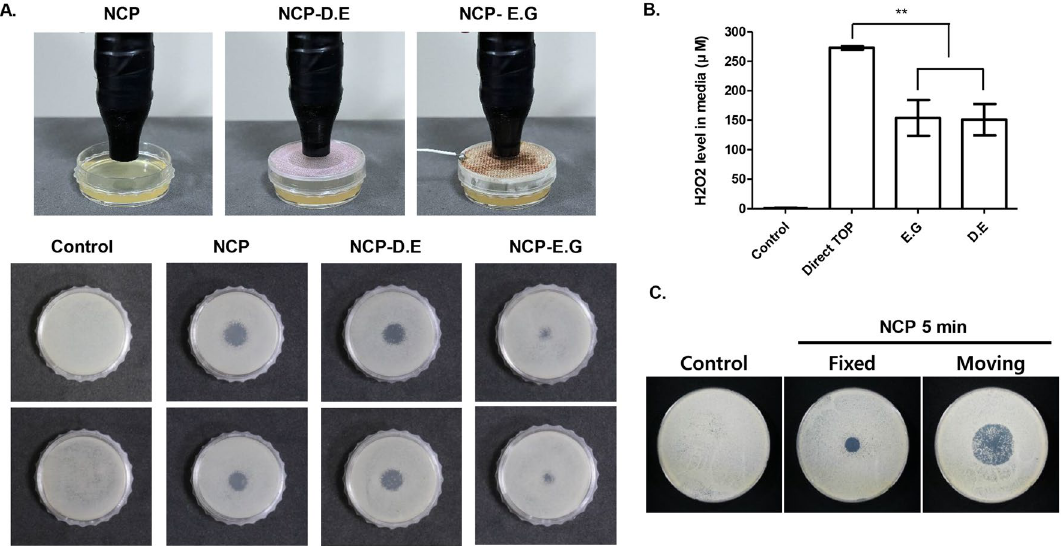
Figure 8. The charged particles of NCP is critical for the NCP-mediated bactericidal in solid medium. ( A ) Upper panel The photographs showing the 3 different NCP treatment conditions. NCP-D.E represents the NCP treatment condition placing a dielectric mesh between the target and NCP device, and NCP-E.G. means a grounded electric meshes were placed during the treatment. Bottom panel: The photographs showing the bactericidal effect of NCP in 3 different treatment conditions. The distance between NCP device and the S.mutans inoculated on solid medium in all three treatment conditions were maintained as 1 cm. At 24 h after the 5 min of NCP treatment, the photographs were taken. ( B ) The effect of 3 different NCP treatment methods on H 2 O 2 level in the liquid medium. 1 ml of liquid medium was treated with NCP for 5 min using 3 different treatment methods described in ( A ). Data shown are the average of three independent experiments, **< 0.01. ( C ). S.mutans inoculated on solid medium was subjected to NCP using two treatment methods. Fixed treatment means NCP device was fixed at the middle of the plate during 5 min of treatment as usual, whereas moving treatment means the NCP was treated in moving manner during 5 min on the circle sized in 3 cm in diameter, keeping 1 cm distance. The photoghraphs showing a clear zone were taken at 24 h after the NCP